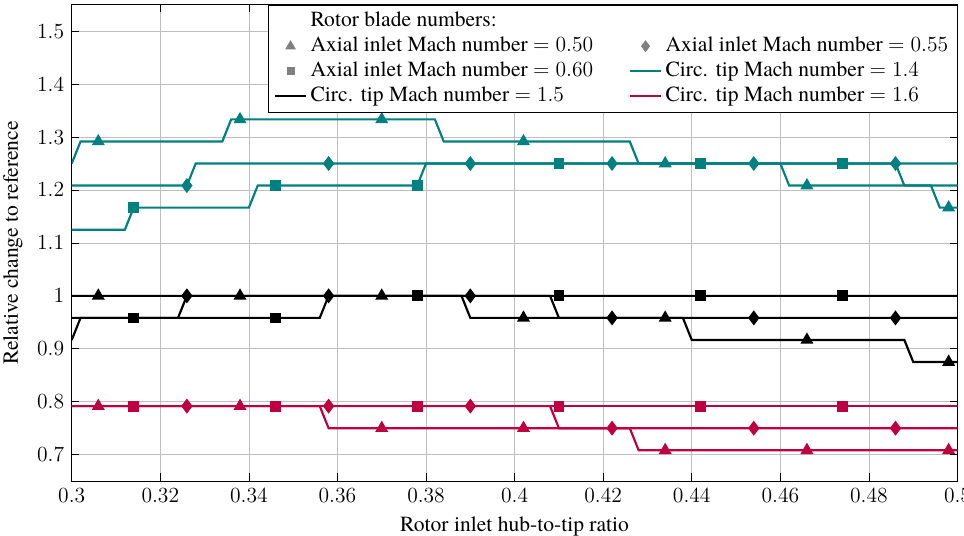
Figure 13. Relative changes in blade numbers over the hub-to-tip ratio in the fan stage, depending on the inlet and circumferential Mach